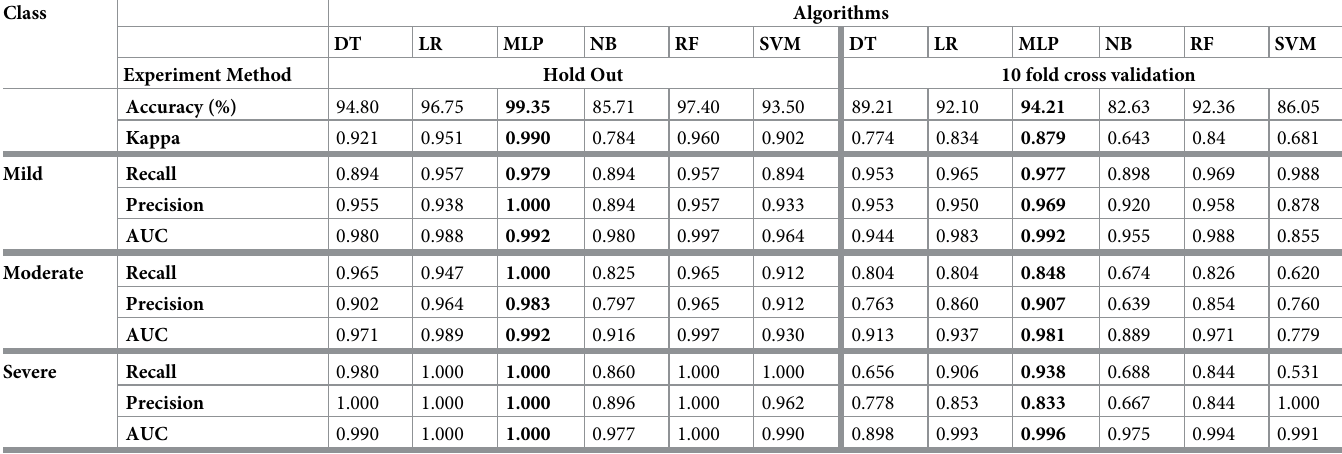
Table 7. Summary of the results obtained using the dataset3 (SMOTE).